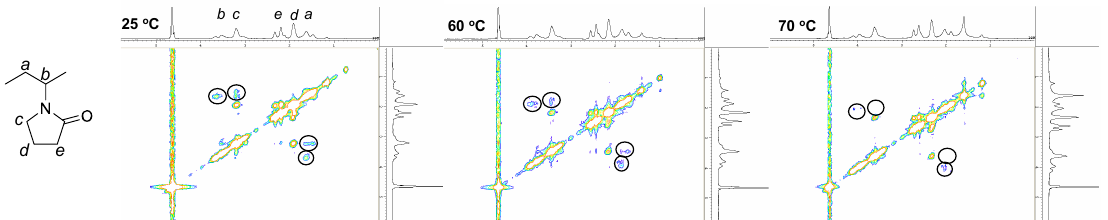
Figure 4. Two-dimensional (2D) 1 H-NMR (NOESY) spectra of PVP- b -PODA micelles measured at 25, 60, and 70 ° C.